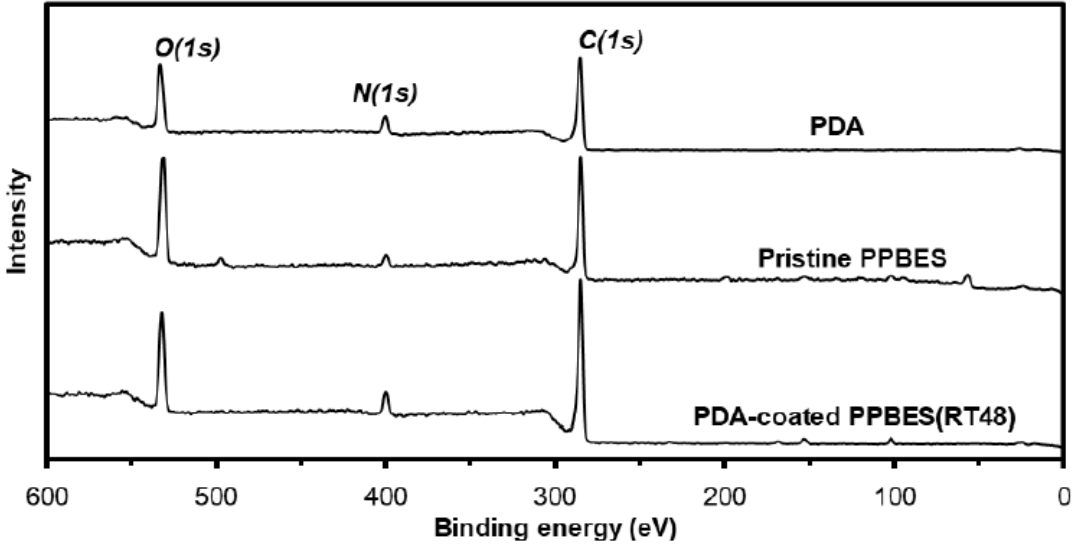
Figure 3. XPS survey spectra of PDA, PPBES, and PDA-coated PPBES.